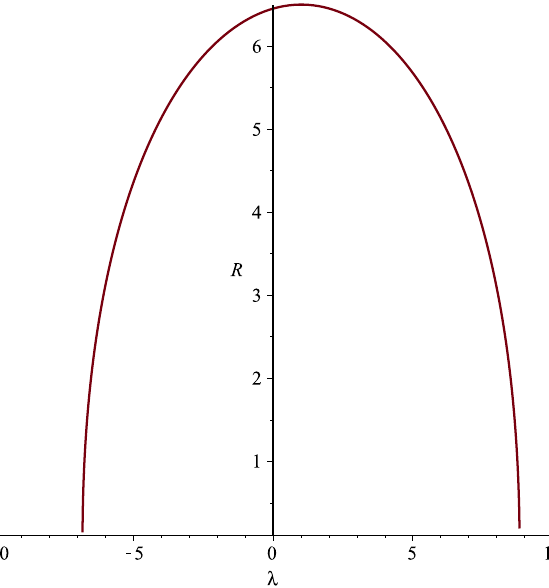
Fig. 1 The arealradius R versus theaffine parameter λ alongthe radial null geodesics of the geometry (16), for the parameter values C 0 = C 2 = 2, C 3 = 3, and λ 0 = 1. Outgoing geodesics slow down as they approach R max , where they stop. Ingoing geodesics starting near R max do so extremely slowly but accelerate as they approach R =